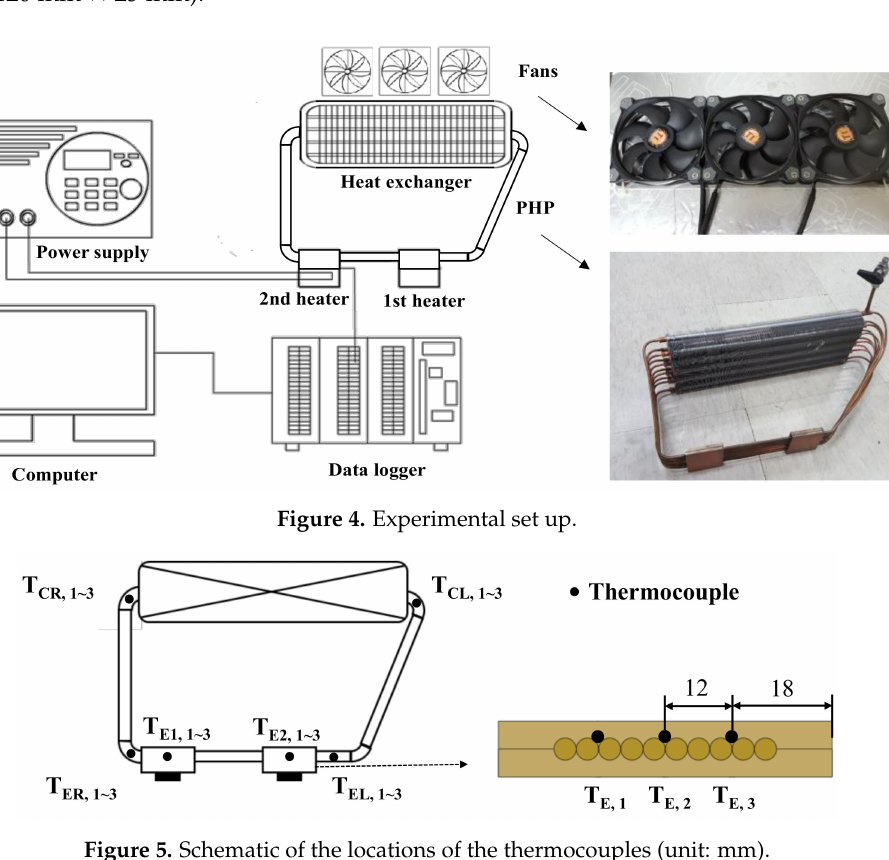
Figure 5. Schematic of the locations of the thermocouples (unit: